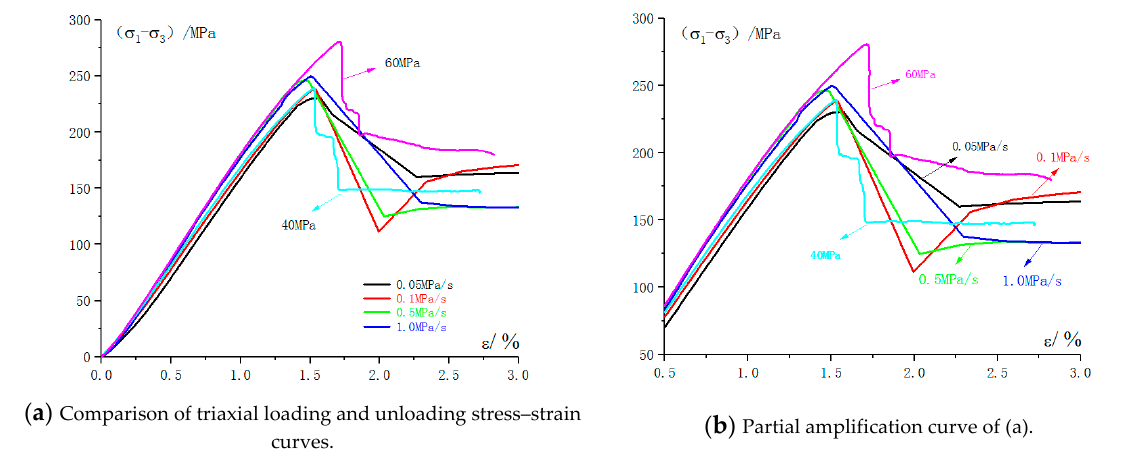
Figure 9. Comparison of triaxial loading and unloading stress–strain curves and partial amplification curve.